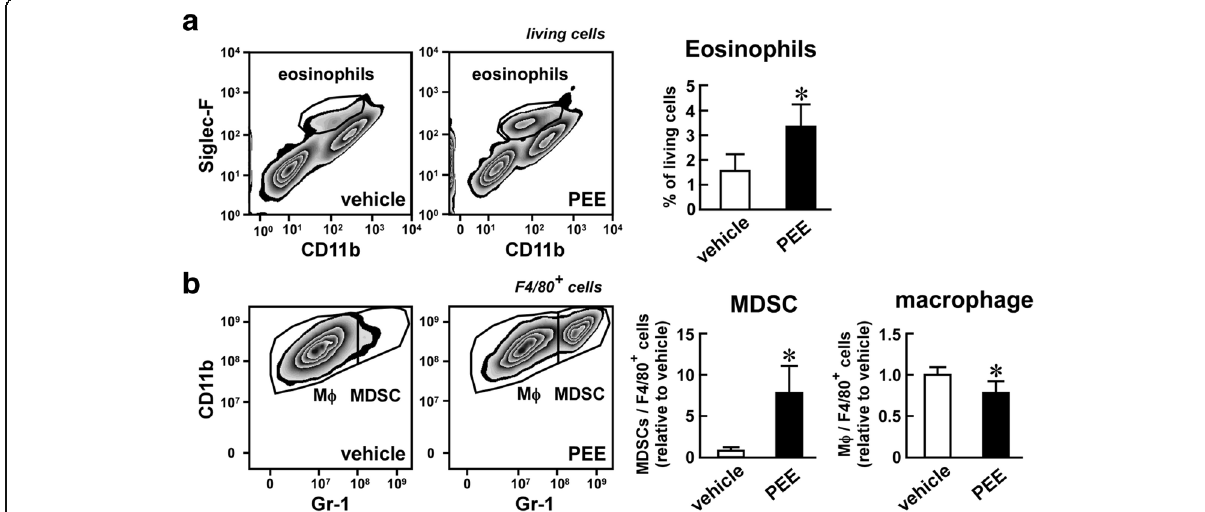
Fig. 1 Effects of propolis ethanol extract (PEE) on the number of eosinophils, macrophages, and myeloid-derived suppressor cells (MDSCs) in the mesenteric adipose tissue of ob/ob mice. PEE (100 mg/kg, twice weekly) or vehicle was intraperitoneally injected into ob/ob mice for one month. Eosinophils, CD11b + , Gr-1 − macrophages, and CD11b + , Gr-1 + MDSCs were subsequently detected by FACS. a Eosinophils in the living cells. b Macrophages and MDSCs in F4/80 + myeloid cells. (Left scatter plots) Representative FACS images of four replicates. (Right graphs) Proportion of eosinophils in the living cells ( a ) and macrophages and MDSCs in F4/80 + myeloid cells ( b ). Data represents means ± SD of four samples. * P < 0.05 vs. vehicle-treated